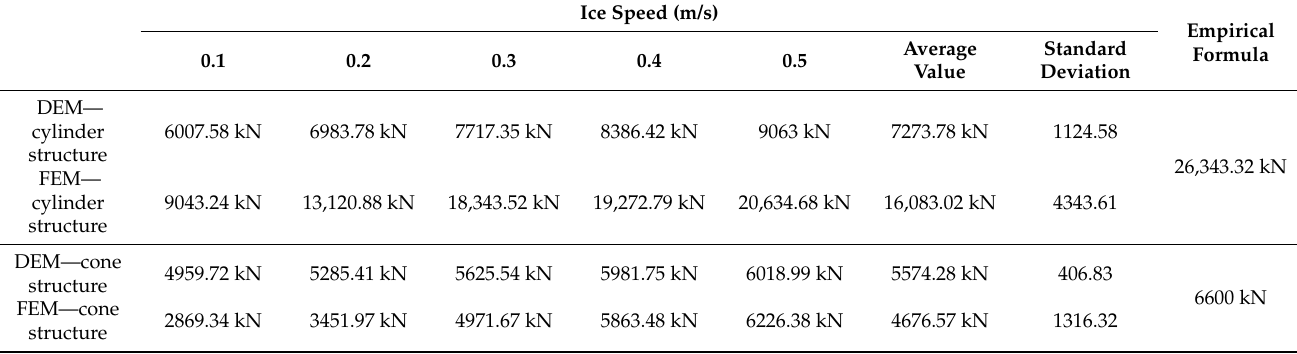
Table 5. The numerical comparison of different ice load analysis methods.